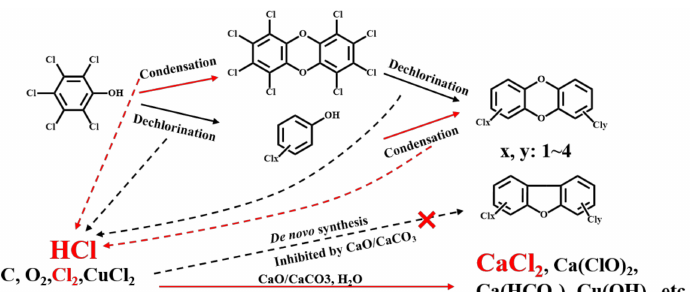
Figure 8. Condensation, dichlorination, and inhibition of PCDD/Fs during co-sintering with MSWI fly